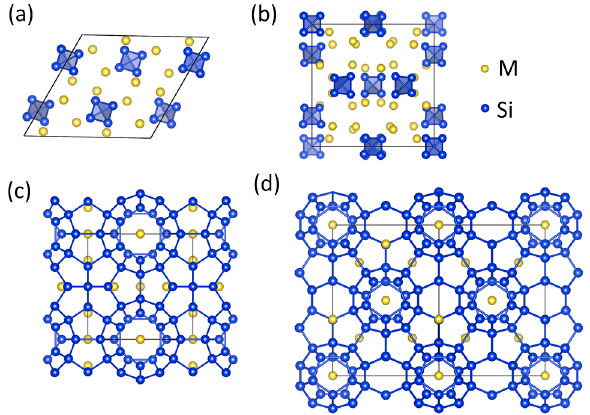
Figure 1. Crystal structures of ( a ) Na 4 Si 4 ; ( b ) M 4 Si 4 ( M = K, Rb, or Cs); ( c ) M 8- x Si 46 ; and ( d ) M 24- x Si 136 .